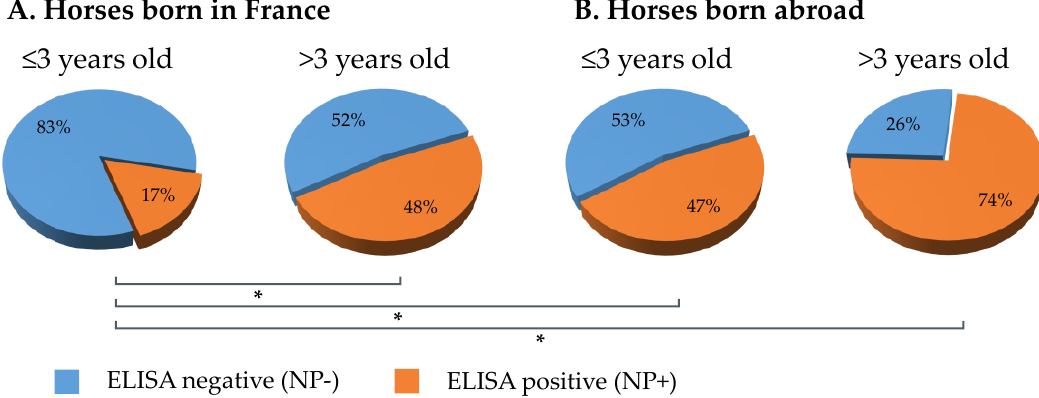
Figure 4. Comparison of equine influenza virus (EIV) nucleoprotein (NP) ELISA results between serum samples from young ( ≤ 3 years) and older ( > 3 years) horses at the time of sampling, which were seropositive by SRH test. Results for horses born in France ( A ) or abroad ( B ). (*) p -value ≤ 0.006. Results were similar when analyzed by geographical regions, except for Auvergne-Rh ô ne-Alpes were the number of samples available was too limited (data not